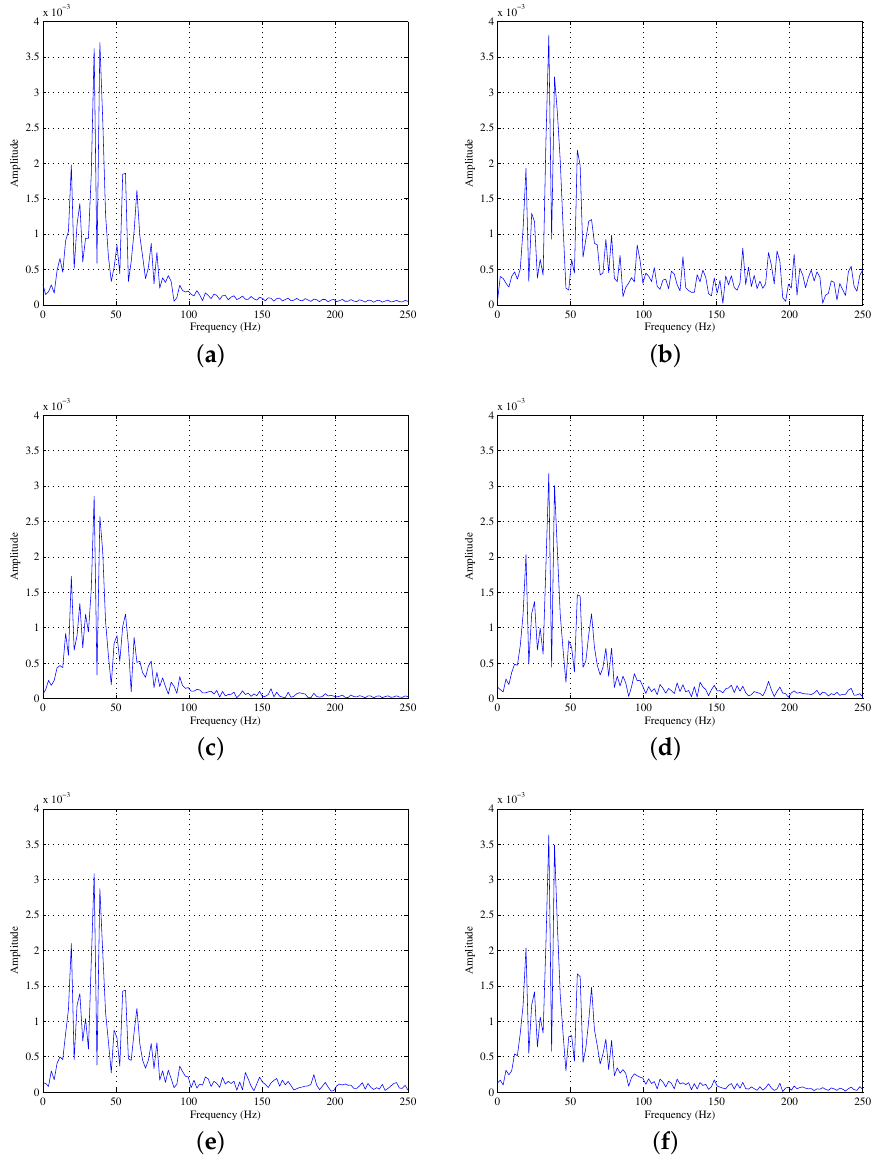
Figure 7. Amplitude spectrum of the denoising result of trace 100 when the SNR of the input noisy seismic signal was 3 dB. ( a ) Spectrum of the noise-free data, ( b ) spectrum of the input noisy data, ( c ) spectrum of the wavelet denoising result, ( d ) spectrum of the ITVD result, ( e ) spectrum of the ATVD result and ( f ) spectrum of the SD-SpaLR